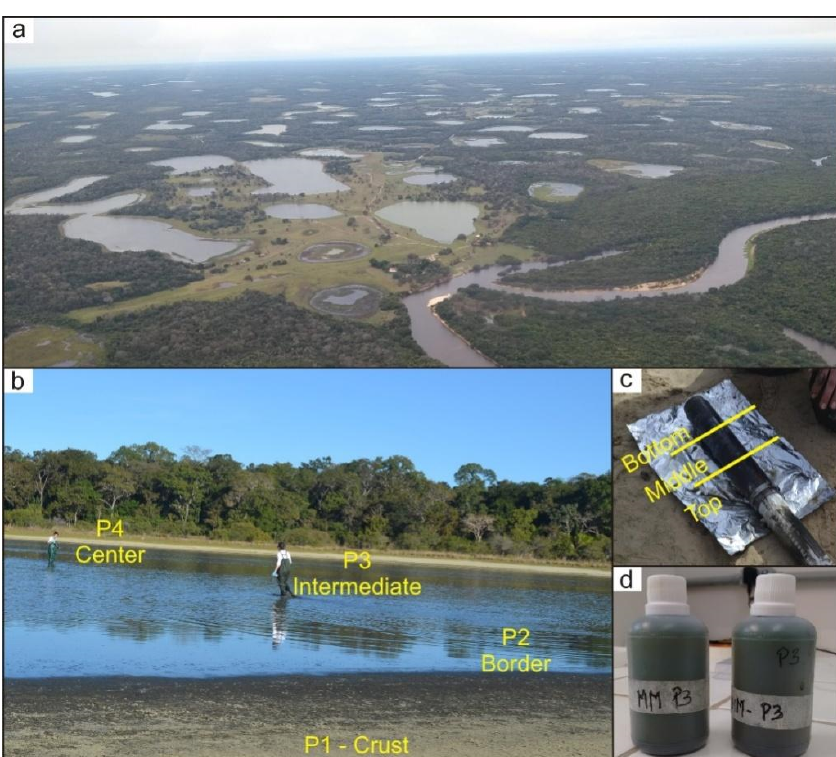
Figure 2. ( a ) Aerial view of Barranco Alto farm; ( b ) sampling points in the margins (formed by sand or a crust of sediments, carbonate and iron oxide) and inside the lakes; ( c ) sampling core with the sediments split in bottom, middle and top portions; ( d ) water samples in plastic containers.